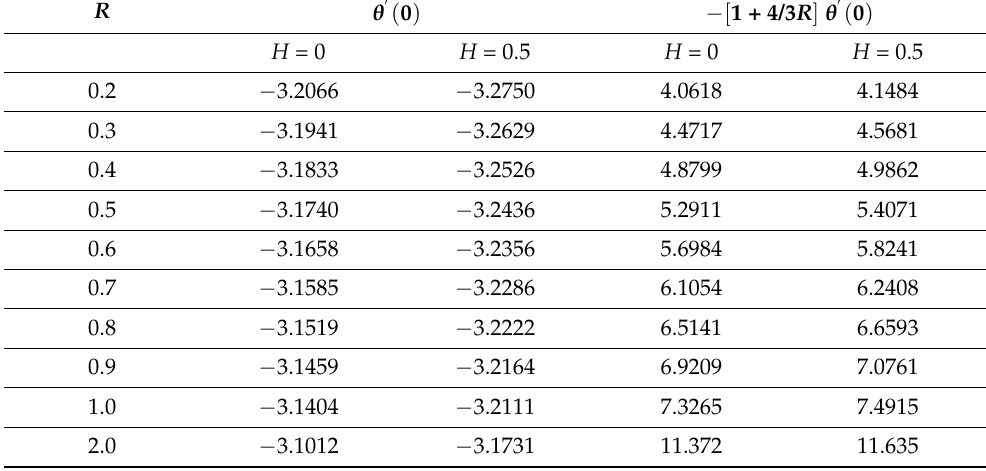
Table 21. Impact of thermal radiation parameter on Nusselt number with and without heat